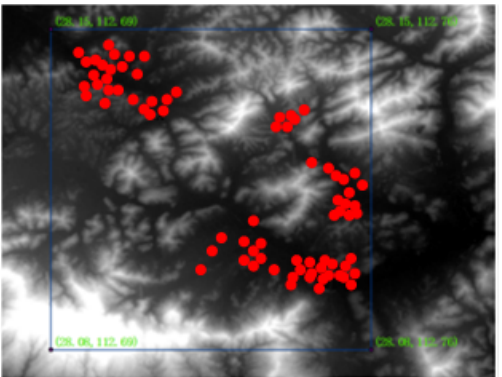
Figure 31. The DEM data of experimental area. The red dots in the figure represent the place where the pictures were taken in the experiments.